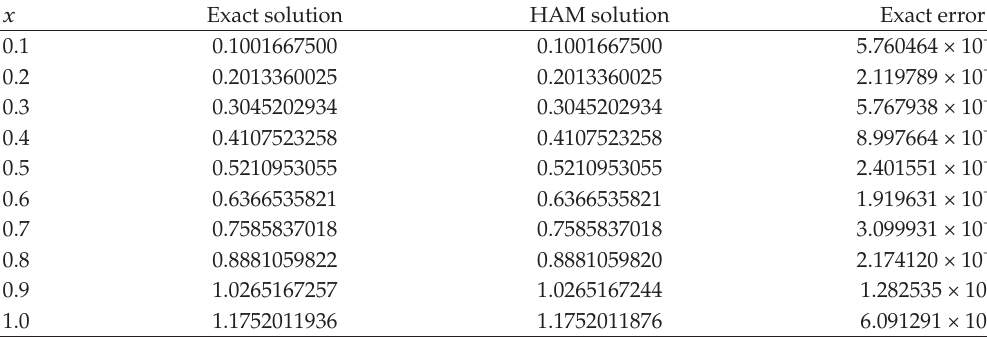
Table 3: Numerical results of (cid:4) 4.18 (cid:5) and (cid:4) 4.19 (cid:5) at (cid:2) (cid:9) − 1 and κ (cid:9) 1 .